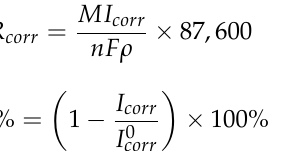
Table 3. Potentio-dynamic polarization parameters of the coatings.